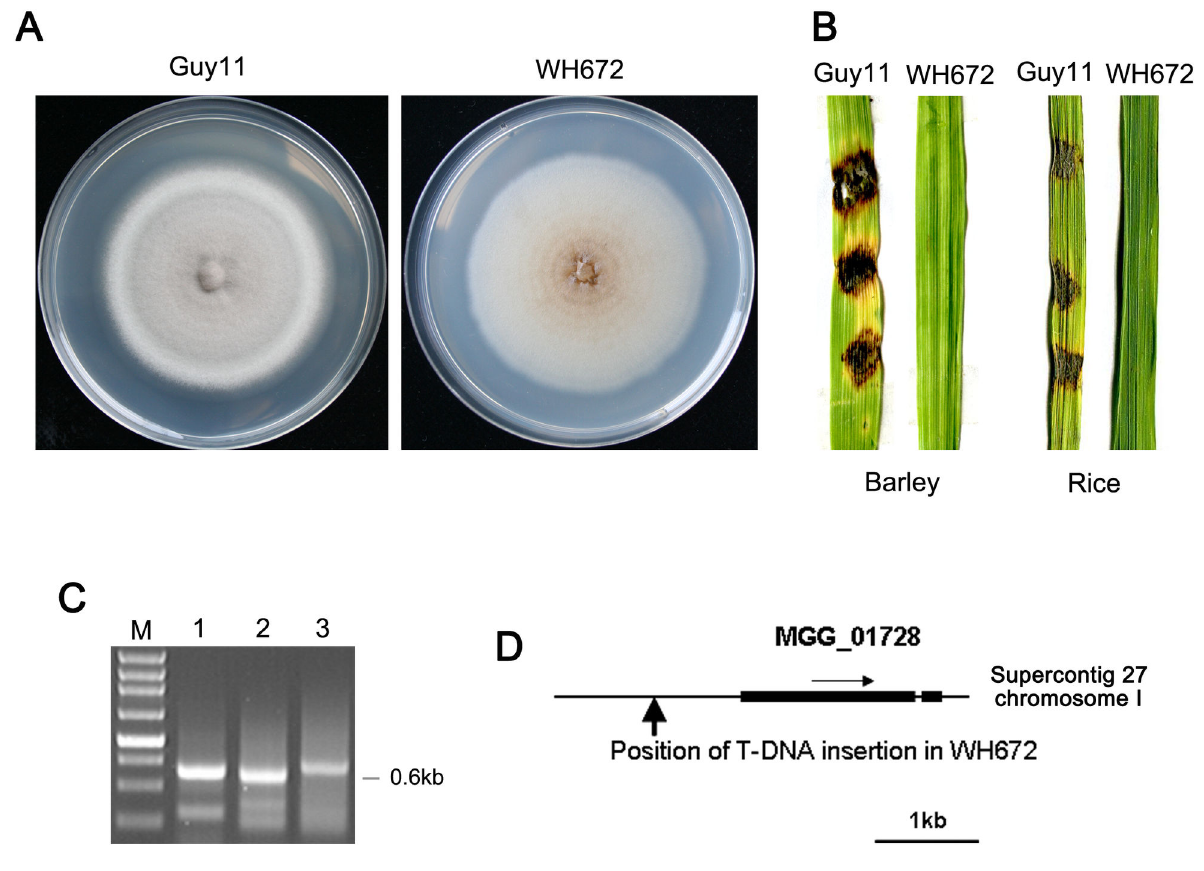
Figure 1. Identification of the non-pathogenic mutant, WH672, and the T-DNA-tagged gene. ( A ) Colonies of the wild type strain Guy11 and T-DNA insertional mutant WH672 on CM medium. ( B ) Barley and rice leaf segments were inoculated with the mycelium plugs from Guy11 and WH672 cultures. ( C ) Three round amplifications of 0.6 kb genomic DNA flanking right site of the integration T-DNA in WH672 using a hiTAIL PCR approach. ( D ) Position of T-DNA insertion in the WH672 mutant strain. Arrow indicates the T-DNA insertion positions in MGG_01728 . Thick boxes represent the coding regions and the thin line joining these coding regions indicates position of the